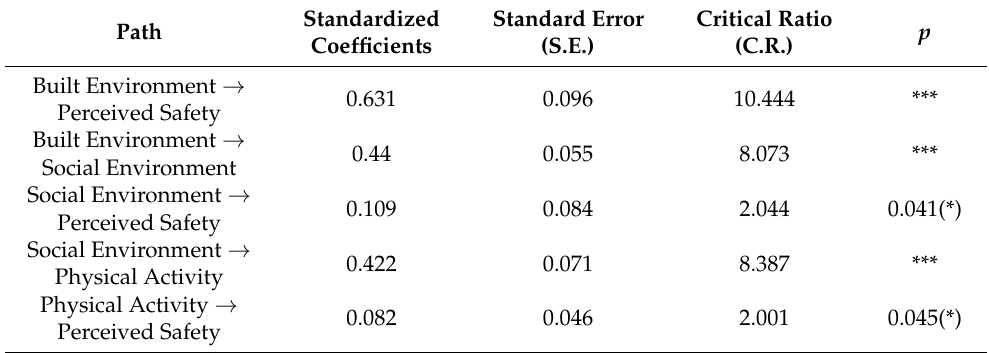
Table 3. Standardized coefficients of SEM.